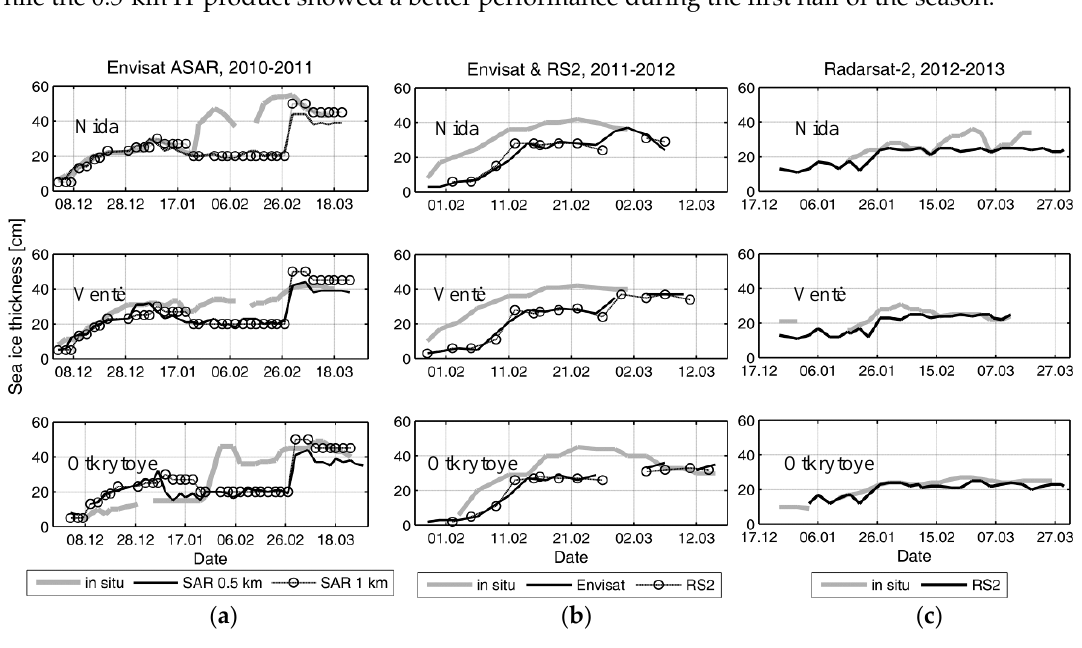
Figure 10. Comparison of Envisat ASAR and RADARSAT-2 ice thickness products with in-situ measurements for winter seasons of 2010–2013 for ( a ) Envisat ASAR 0.5-km and 1-km products in 2010–2011, ( b ) Envisat ASAR 0.5-km and RADARSAT-2 0.5-km products in 2011–2012, ( c ) RADARSAT-2 0.5-km in 2012–2013.